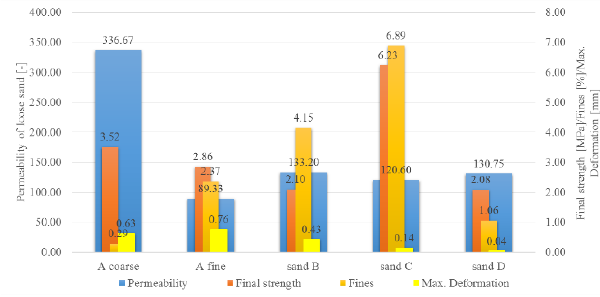
Figure 21. Final comparison of strength, permeability, fines content, and deformation of base materials.